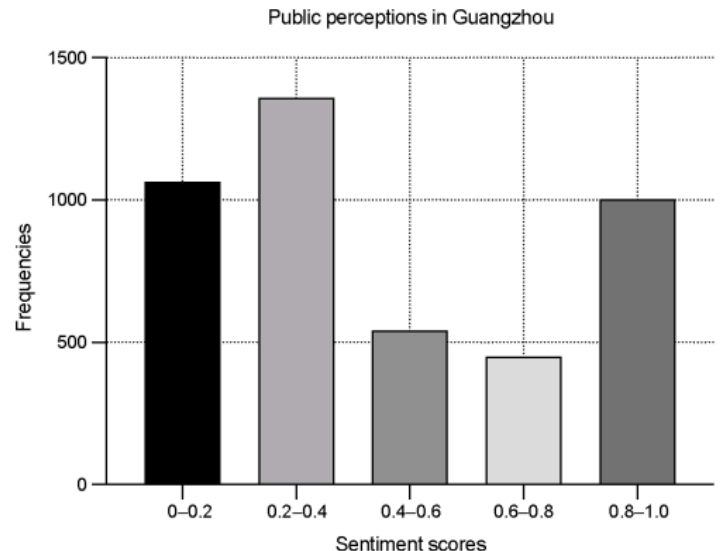
Figure 2. Sentiment score of UGSs in Guangzhou.